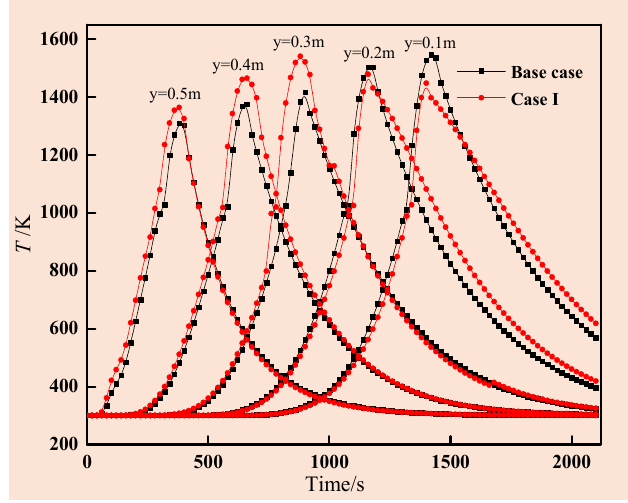
Figure 11. Temperature evolution curves of CS (Base case) and FSDS (Case I).